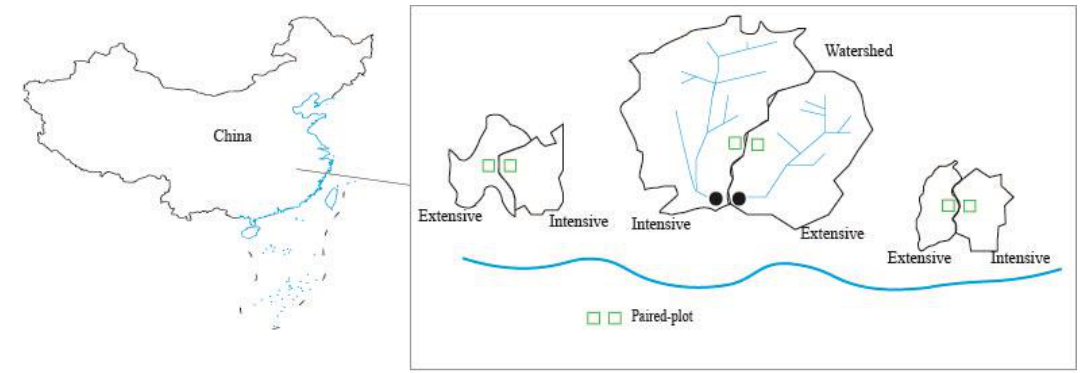
Figure 1. Location of three paired-plots and two small watersheds.